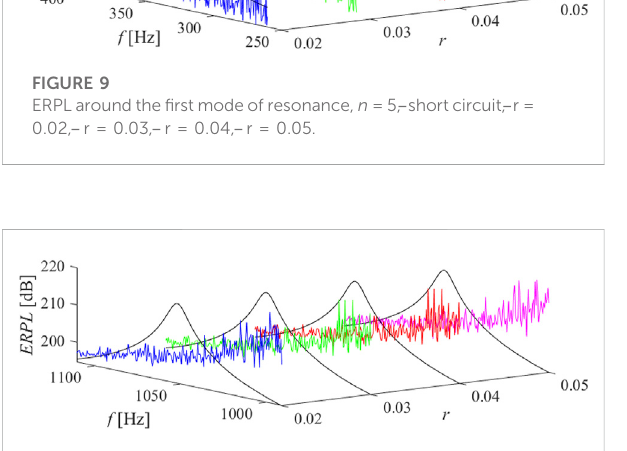
FIGURE 10 ERPLaroundthesecondmodeofresonance, n =4, ̶ shortcircuit, ̶ r = 0.02, ̶ r = 0.03, ̶ r = 0.04, ̶ r = 0.05.